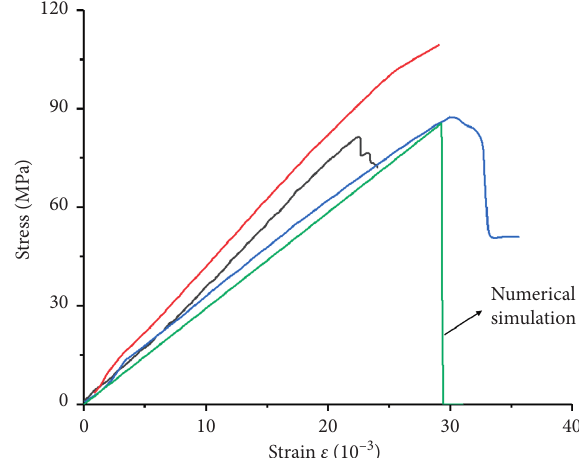
Figure 3: Comparison of the uniaxial compression curves from the numerical simulation and laboratory